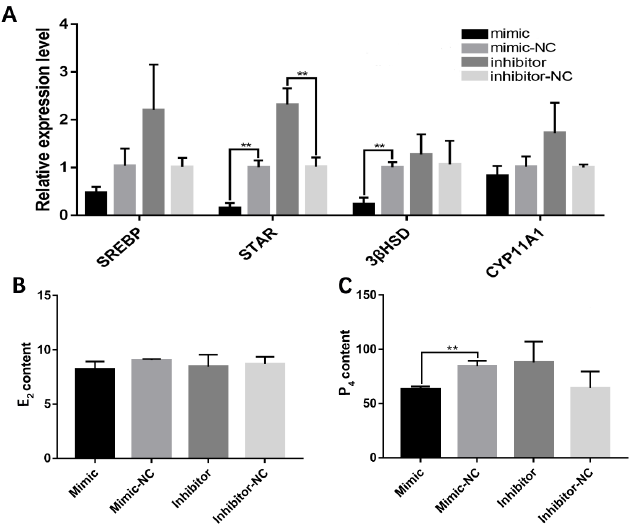
Figure 3. miR-202-5p blocks the secretion of steroid hormone in goose granulosa cells. ( A ) effects of the overexpression or interference of miR-202-5p on the expression levels of several steroidogenesis- related genes, and ( B , C ) effects of the overexpression or interference of miR-202-5p on the secretion of E2 and P4. ** p < 0.01.